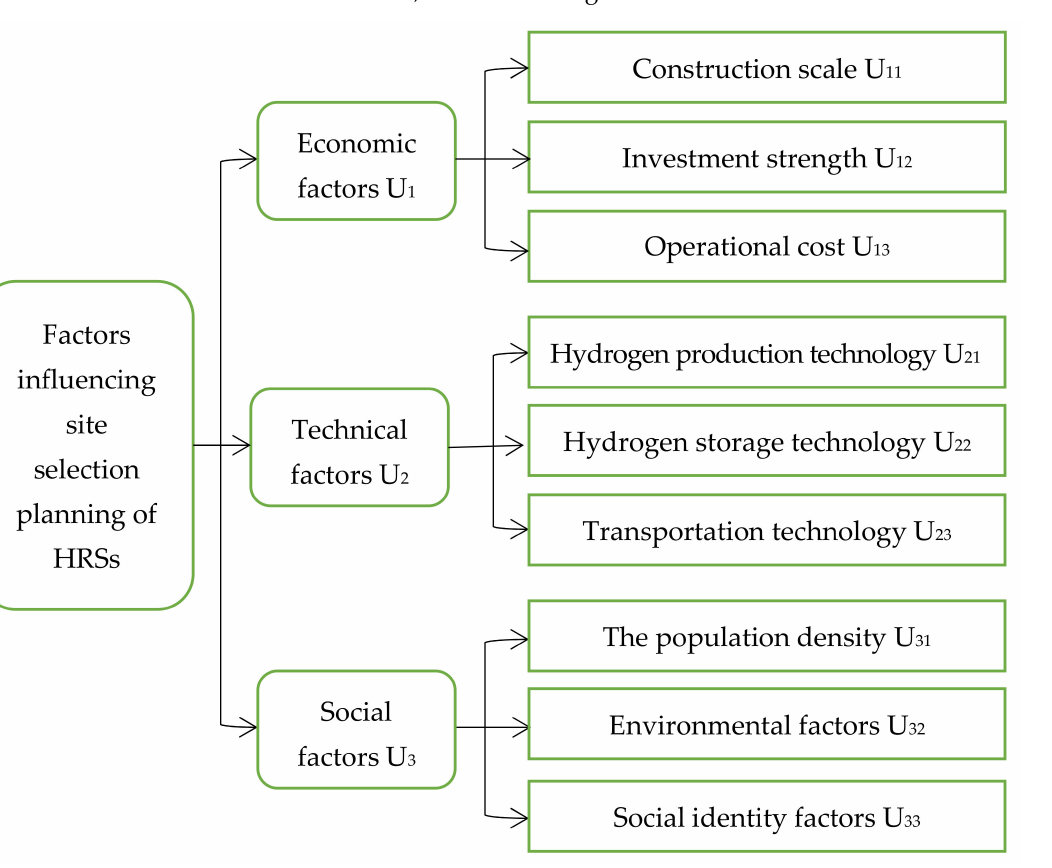
Figure 2. Evaluation index system of HRSs site